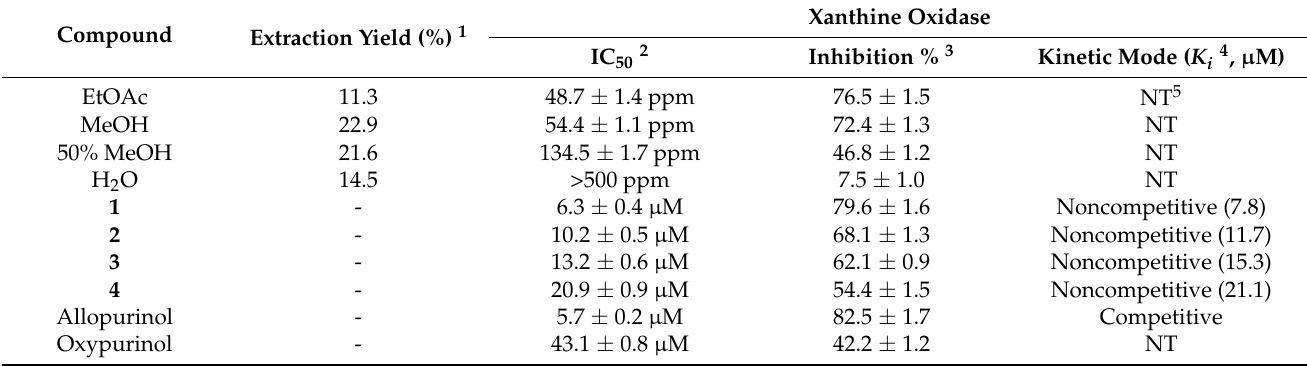
Table 1. Inhibitory effects of the rhizome extract of Dryopteris crassirhizoma using different solvents and isolated compounds 1 – 4 on xanthine oxidase activities.